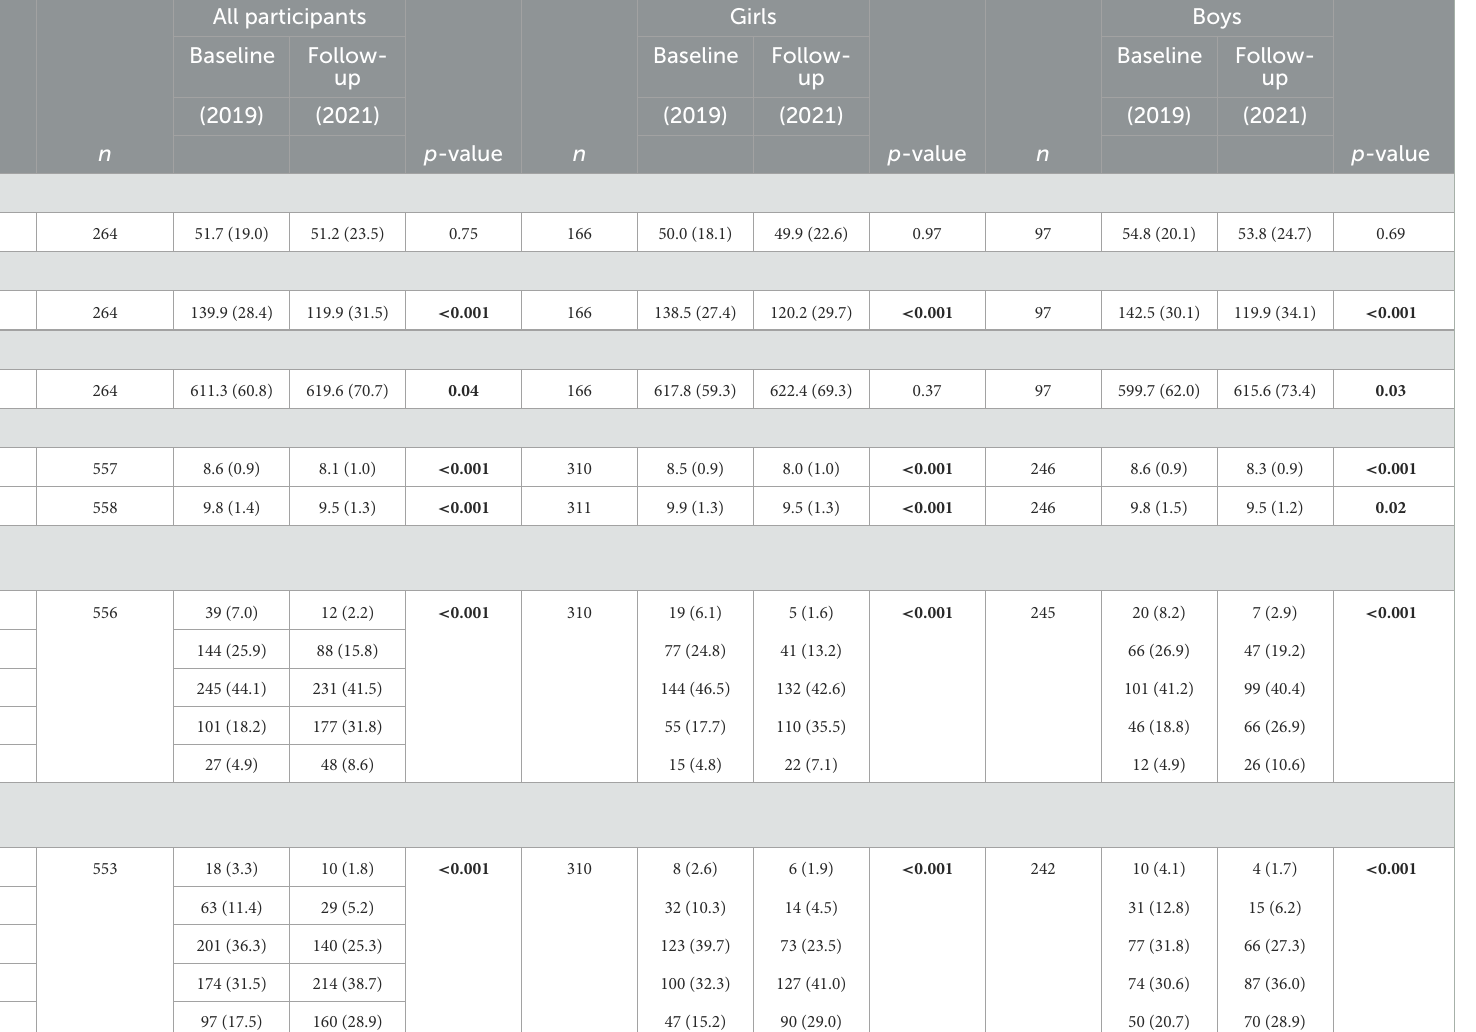
All participants Girls Boys Baseline Follow- up